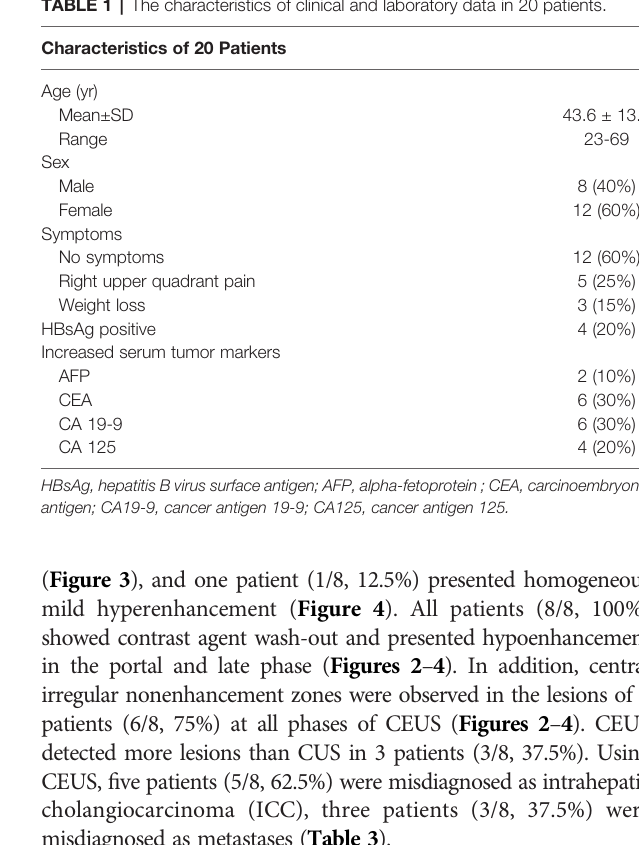
TABLE 1 | The characteristics of clinical and laboratory data in 20